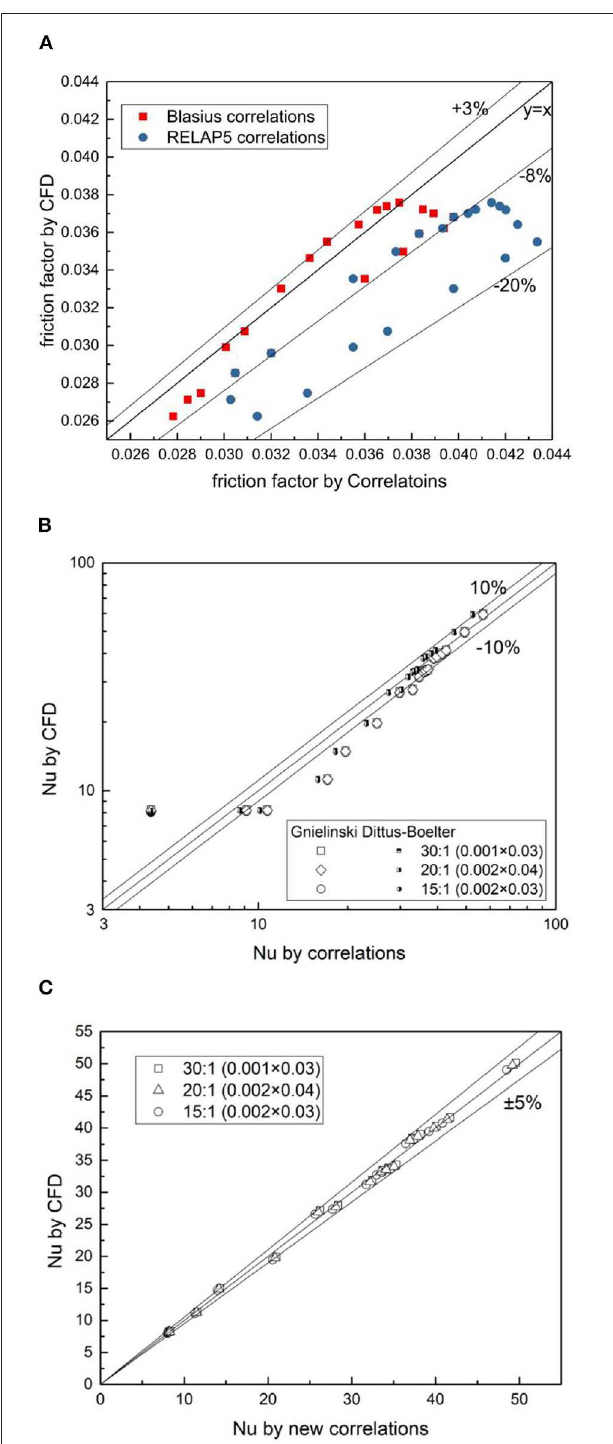
FIGURE 2 | Assessments of friction factor and heat transfer correlations. (A) Assess the RELAPS5 and Blasius correlation for friction transfer. (B) Assess the RELAPS5 and Gnielinski correlation for heat transfer. (C) Assess the new developed correlation for heat